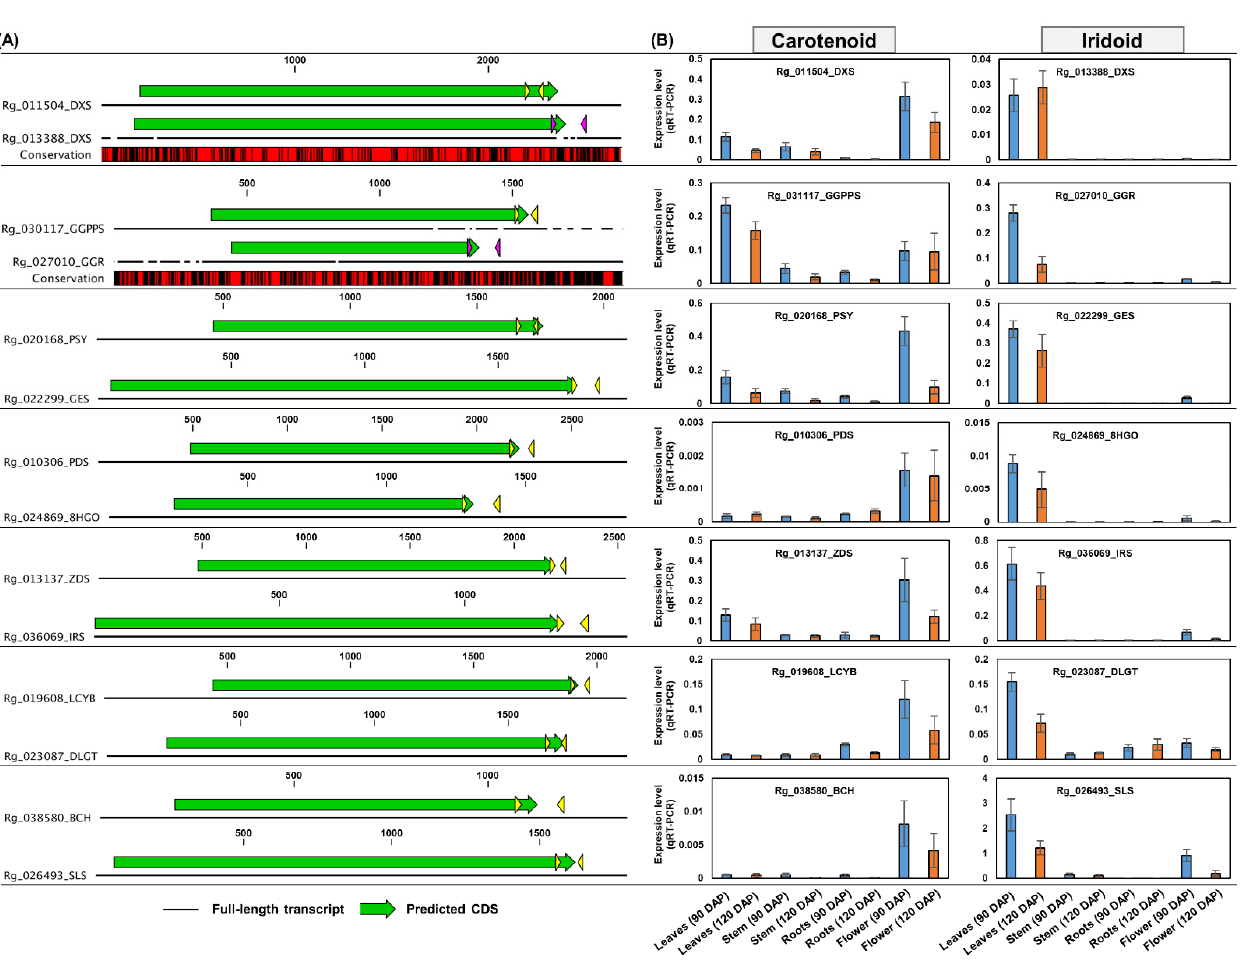
Figure 10. qRT ‐ PCR analysis of carotenoid and iridoid biosynthesis genes via MEP pathway. ( A ) Schematic diagram of the nucleotide sequence structure of genes involved in carotenoid and iridoid biosynthesis. Colored arrows indicate specific primer positions for the amplification of each gene. Red regions in conservation boxes indicate identical sequences between homologous genes. ( B ) qRT-PCR analysis. The real expression level of each gene was calculated using the delta-CT method and visualized using a bar plot. Error bars represent standard deviations (SD) among three replicates. MEP , methylerythritol